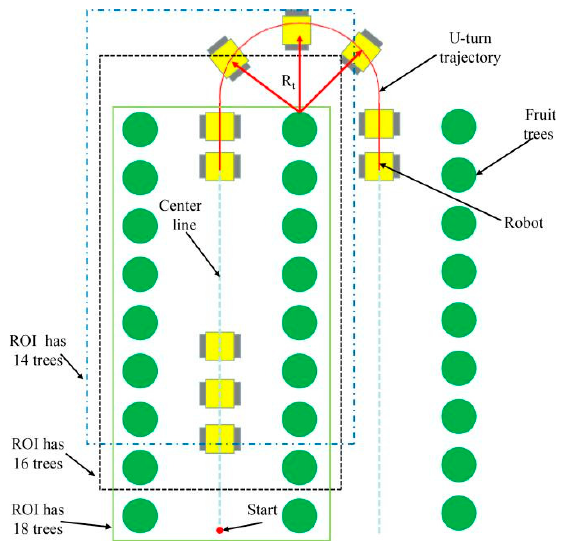
Figure 8. Diagram of PVSR turning.